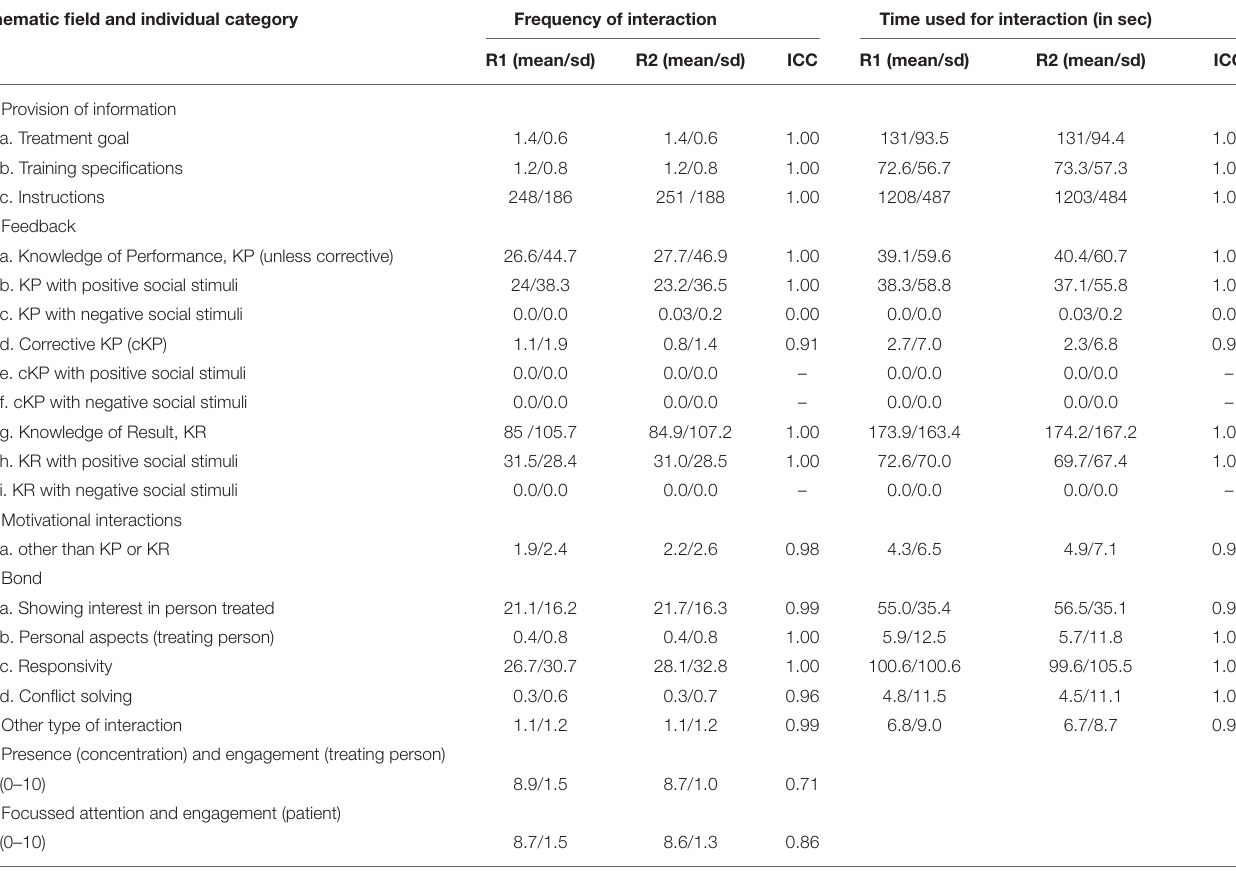
TABLE 3 | THER-I-ACT observations and inter-rater-reliability–individual categories ( n = 29). Thematic field and individual category